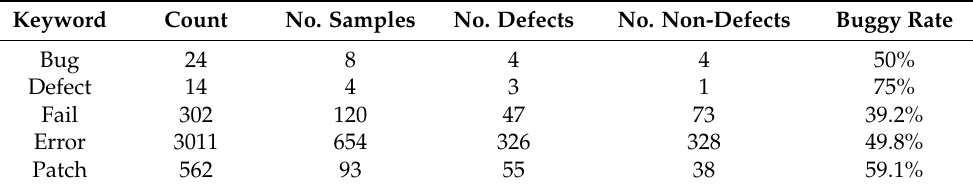
Table 7. Relationship between keywords used in CodeBERT-PK and buggy